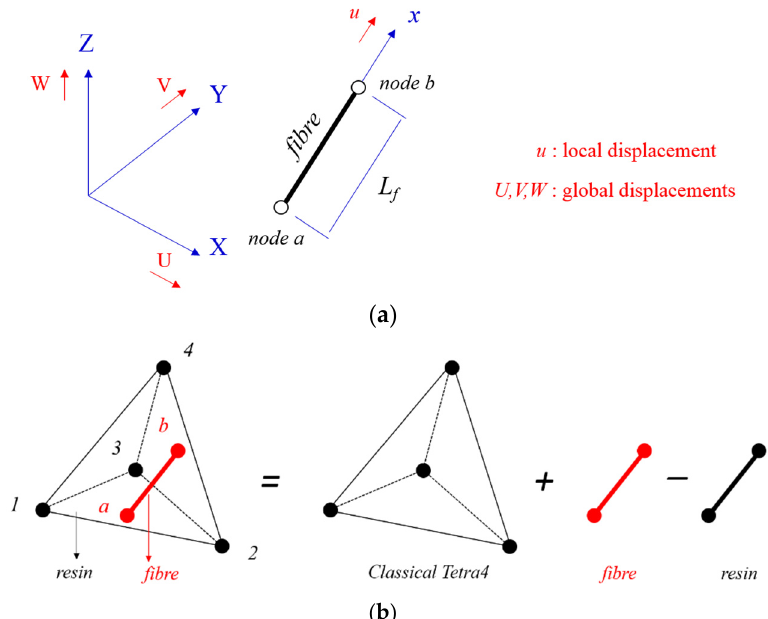
Figure 3. ( a ) Truss fiber element; ( b ) 3D projected fiber reinforcement procedure.